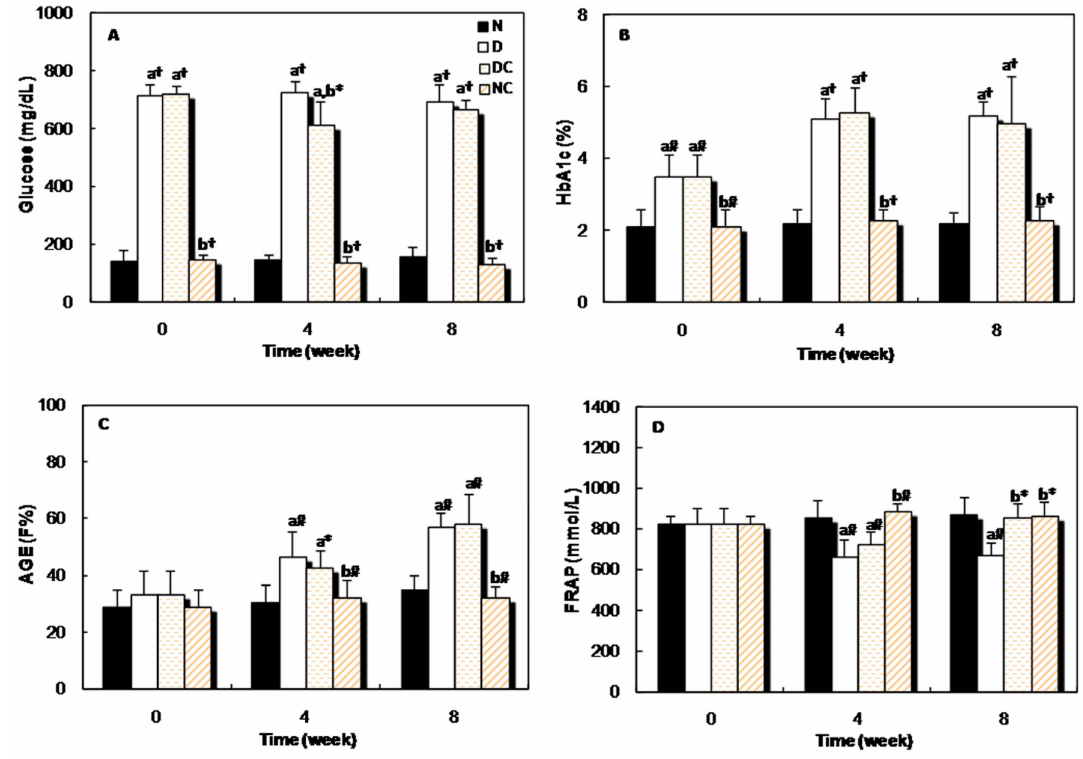
Figure 6. Changes in the ( A ): glucose concentration; ( B ): percent of HbA1c; ( C ): fluorescence intensity of AGEs; and ( D ): FRAP, in different groups of rats at the beginning (0 week), middle (4 weeks), and at the end (8 weeks) of the experiment. “a” indicates the significance of the data that compares group N vs. all groups. “b” indicates the significance of the data that compares group D vs. groups of crocin(s)-treated rats. *, p < 0.05; #, p < 0.01; and †, p < 0.001.